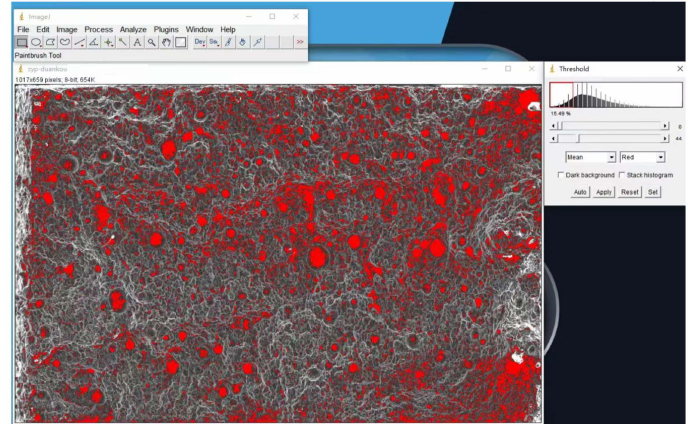
Figure 16. Porosity results of quantitative analysis.